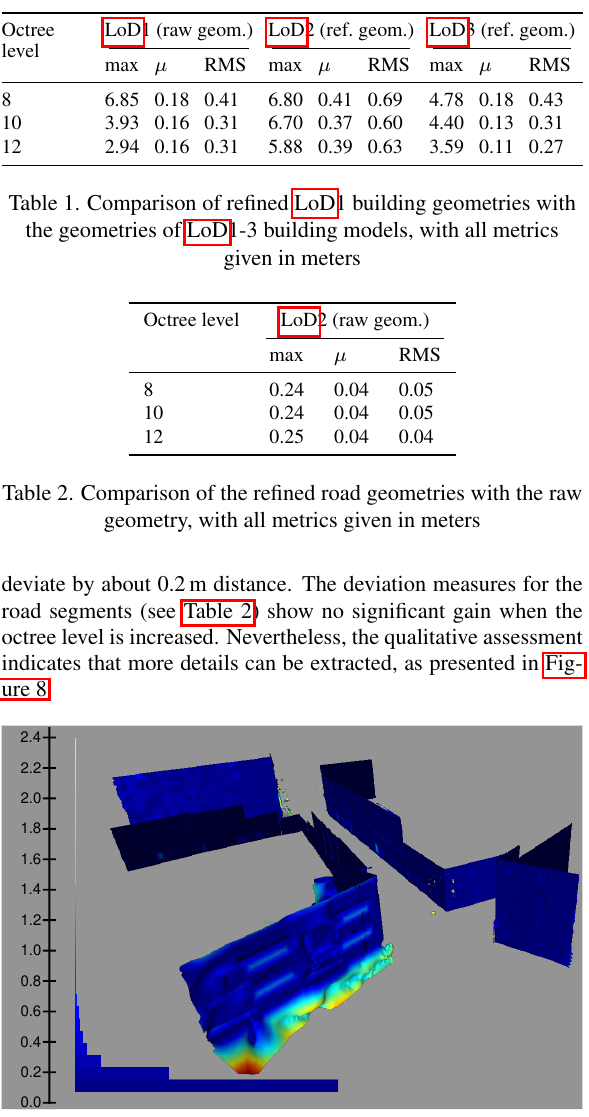
Figure 10. Deviations, obtained by Hausdorff metric given in meters, projected to refined structures at level 12 in comparison to LoD3 buildings